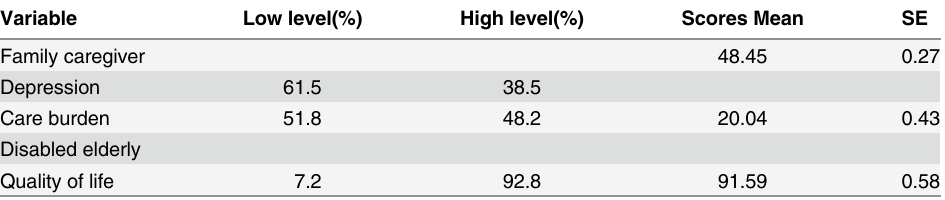
Table 2. Prevalence and score on depression and care burden of informal caregivers and the quality of life of disabled